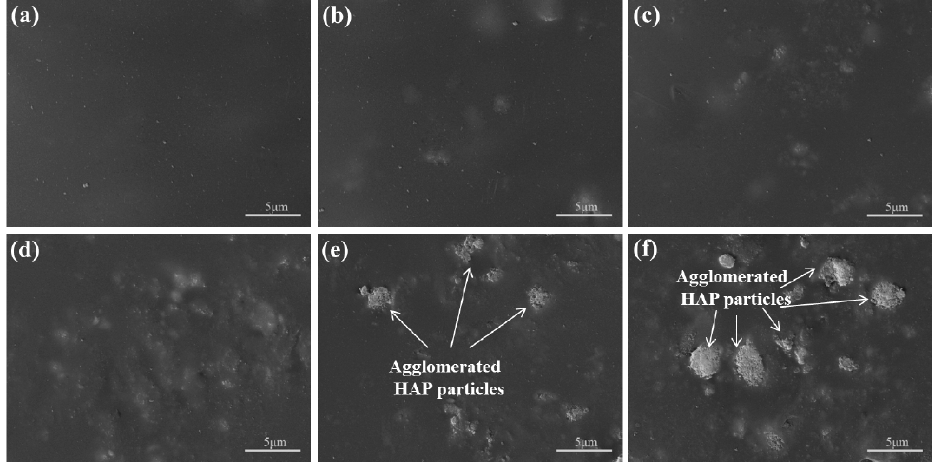
Figure 2. Morphologies of the scaffolds with ( a ) 0 wt %; ( b ) 5 wt %; ( c ) 7.5 wt %; ( d ) 10 wt %; ( e ) 12.5 wt %; ( f ) 15 wt % HAP.